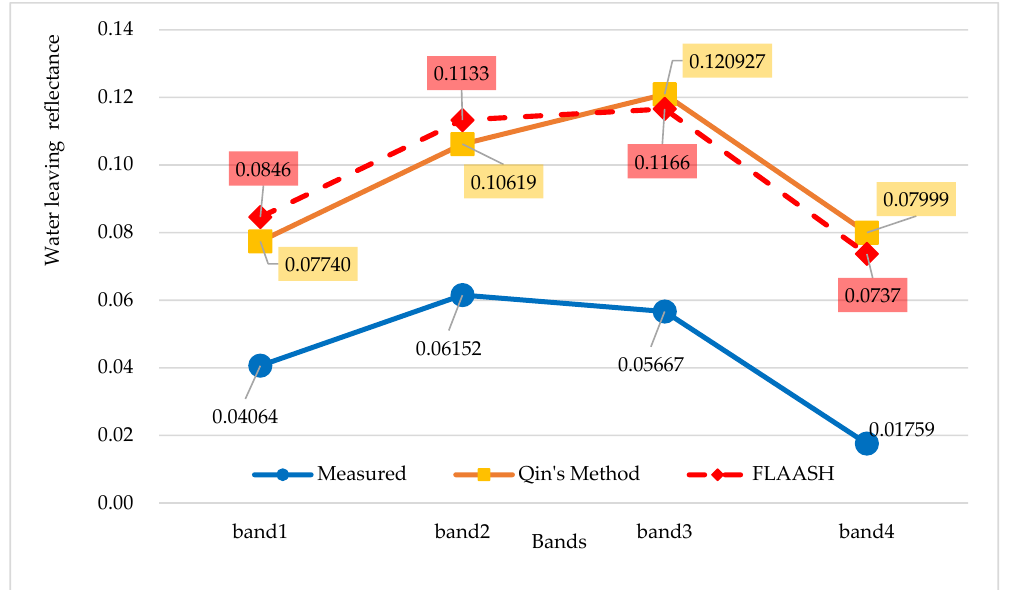
Figure 12. Water leaving reflectance of the A1 sampling site.